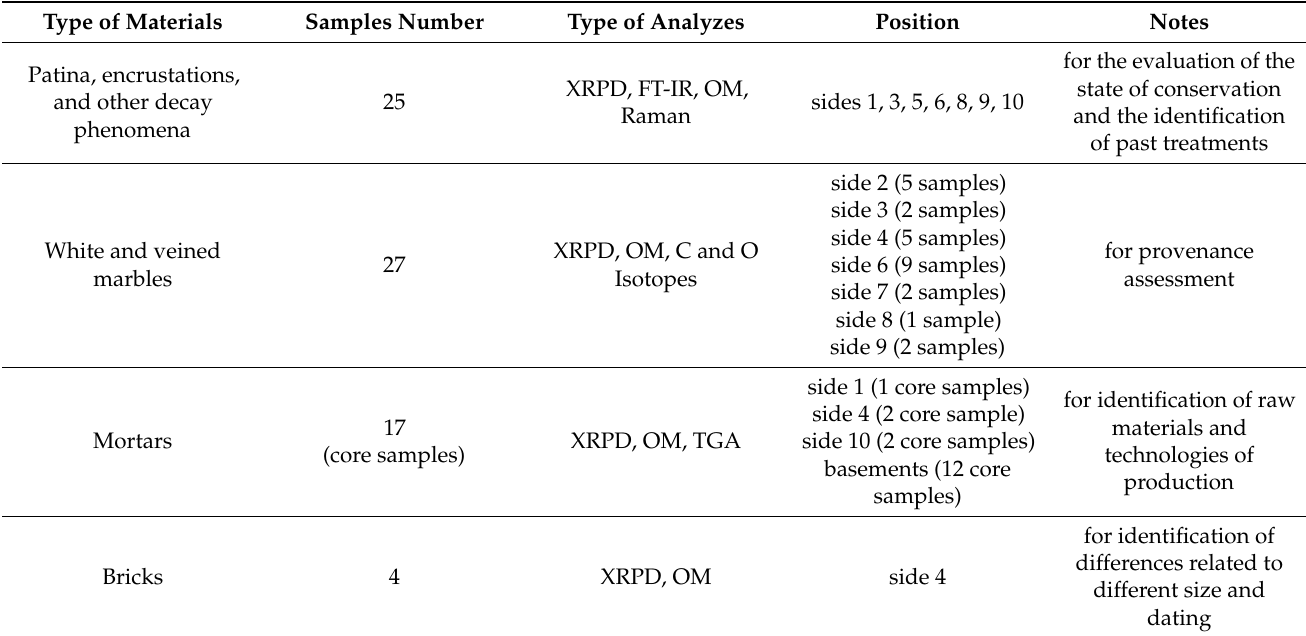
Table 1. List of the collected stone materials samples, their localization on the monument, and the analytical methodologies applied in the